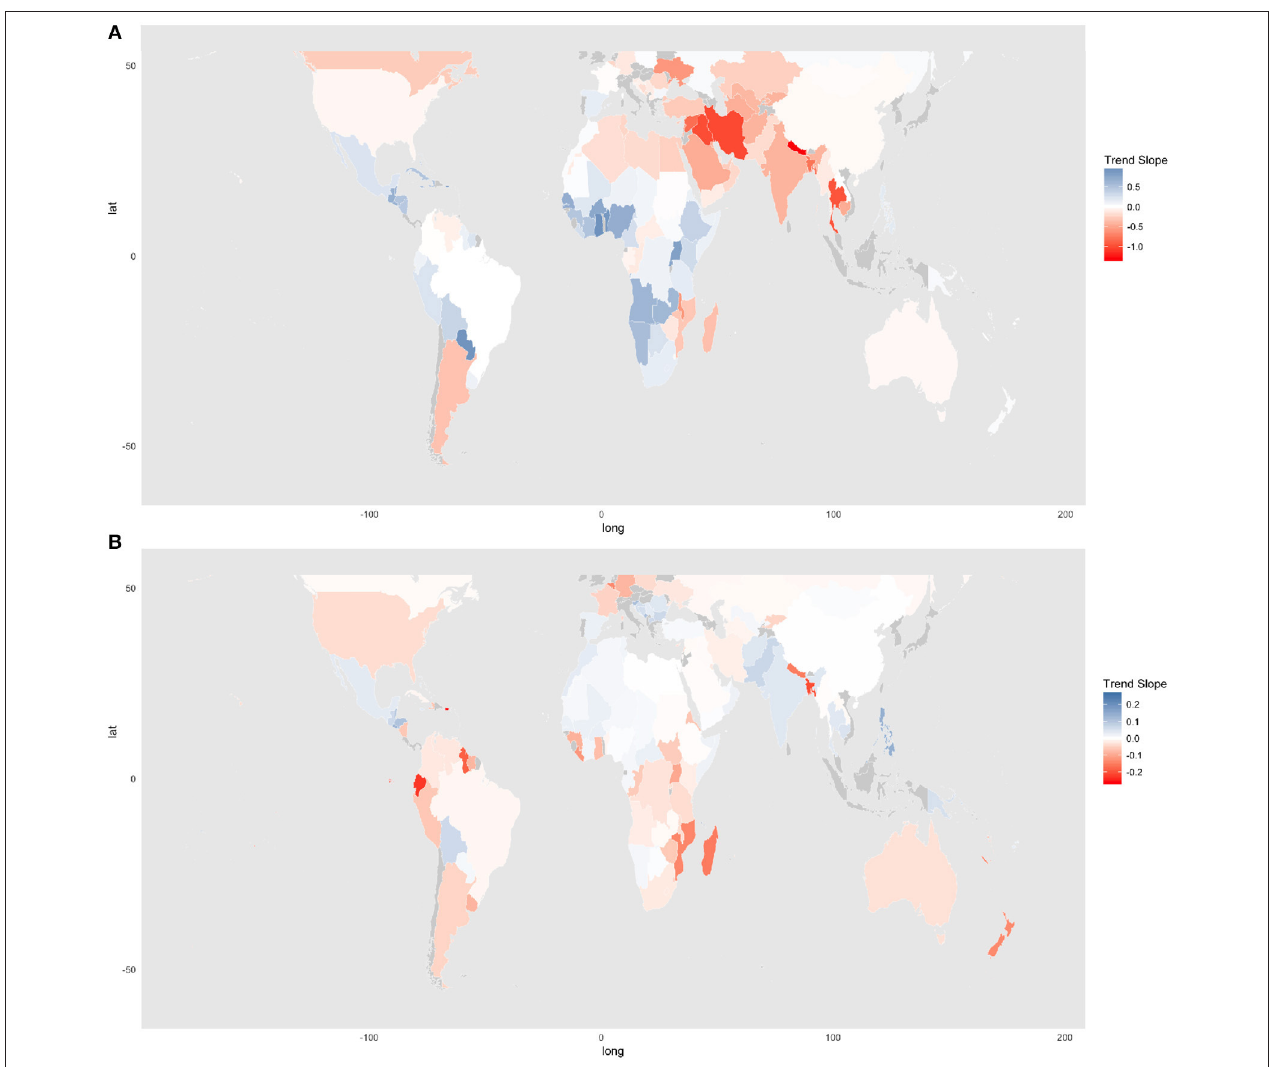
Figure 1 (bottom graph). Trends in precipitation over the period of GRACE record align with the GRACE trends in some regions, but in many regions there is no clear association between water storage trend and precipitation